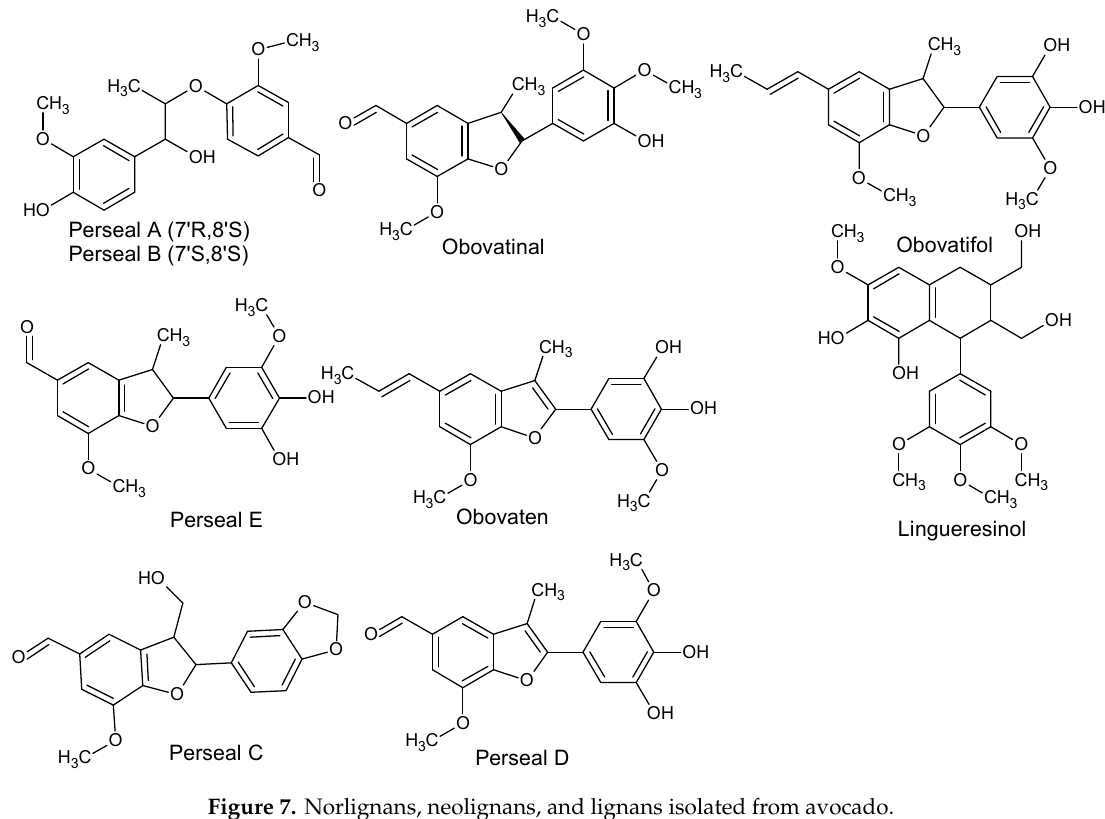
Antioxidants 2019 , 8 , x FOR PEER REVIEW Figure 7. Norlignans, neolignans, and lignans isolated from avocado. Figure 7. Norlignans, neolignans, and lignans isolated from avocado.